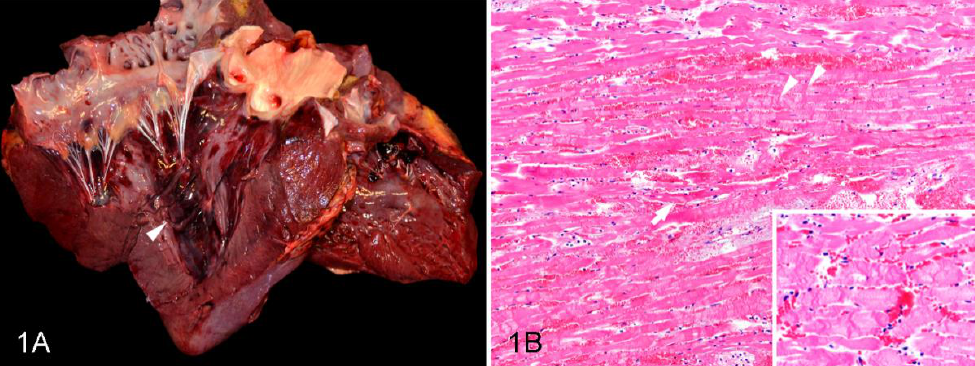
Figure 1. Cardiac lesions in a horse with oleander poisoning; case 20. ( A ) Gross aspect of the heart. Multiple hemorrhages on the endocardium and subendocardial myocardium. The left papillary muscle has been sectioned and the hemorrhages can be seen penetrating deep into the myocardium. ( B ) Microscopic changes in the myocardium. Cardiomyocyte degeneration and necrosis characterized by swelling, hypereosinophilia, loss of cross-striations with fragmentation (arrow), hypercontraction bands (arrowheads), and interstitial hemorrhage and edema. Inset: Detail of the hypercontraction bands. Hematoxylin and